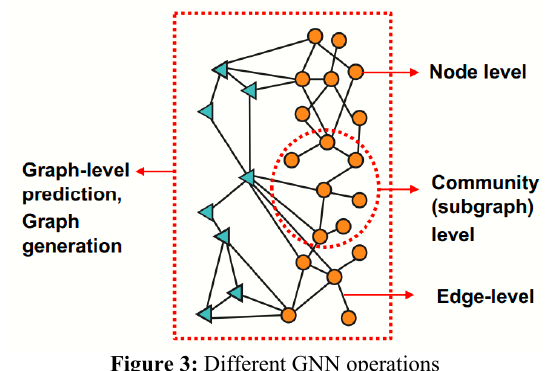
Figure 3: Different GNN operations